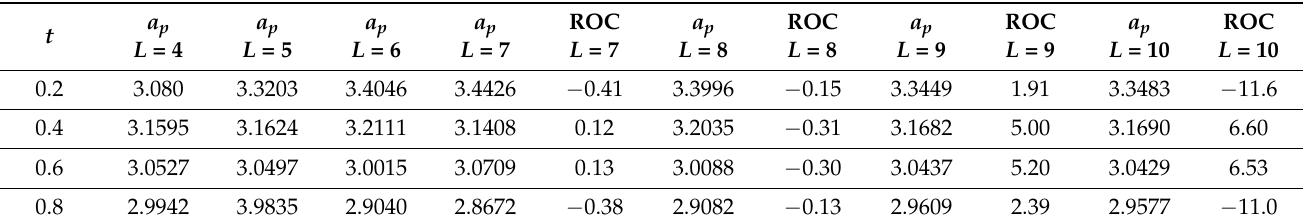
Table 11. The values of a p and rate of convergence (ROC) at different points for k = 0 and various values of L by sine– cosine wavelets.